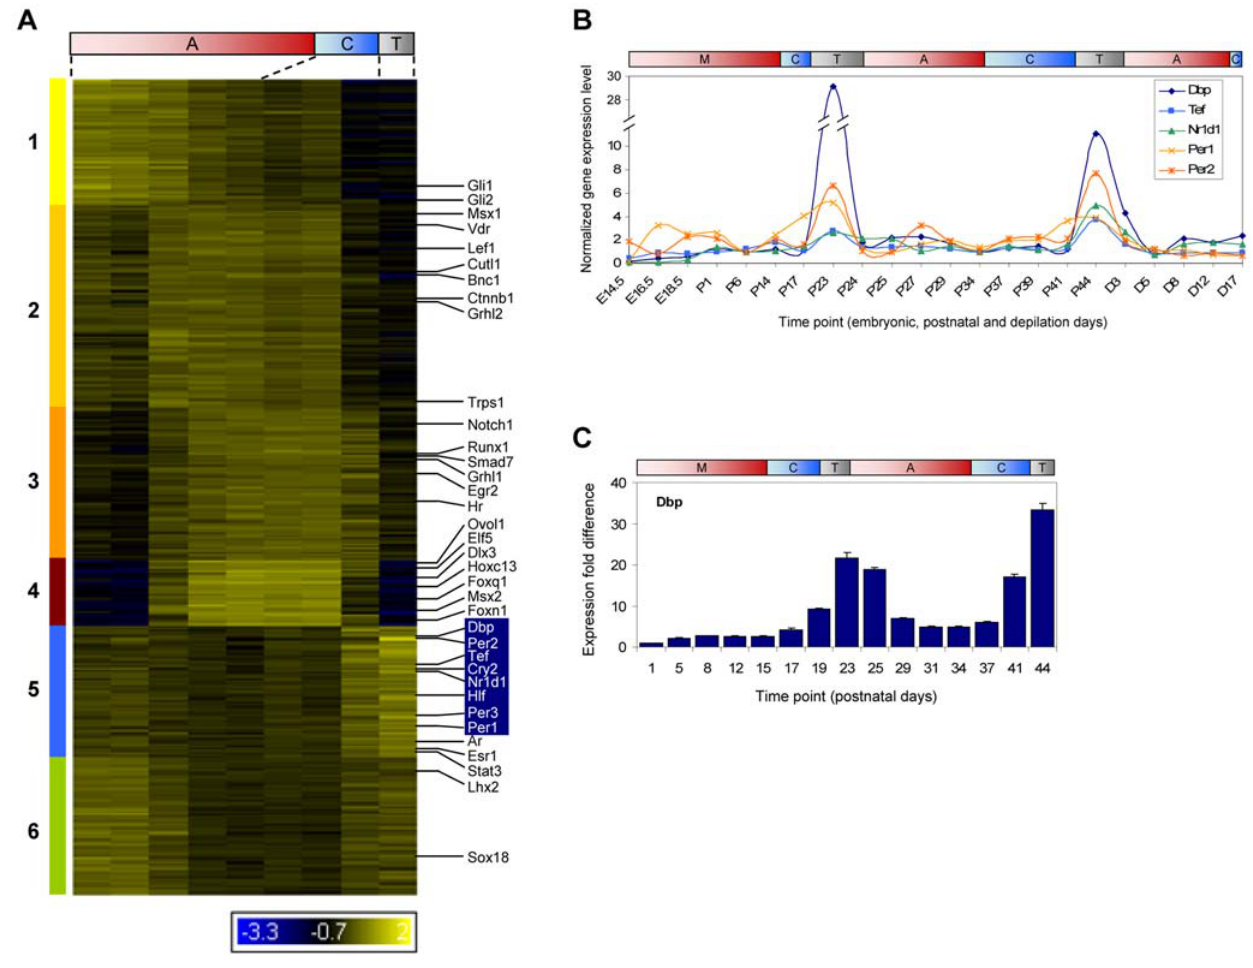
Figure 2. CLOCK–regulated genes are periodically expressed during hair follicle cycling. (A) Temporal clusters (labeled 1–6 and color coded) of hair cycle-regulated transcriptional regulators. Transcription factors that play key roles in hair follicle morphogenesis and/or cycling are labeled with gene symbols in black. CLOCK-regulated genes are labeled in the blue box. Expression levels are from profiling data of the second hair growth cycle and are indicated by the colorimetric ratio-scale. (B) Time-course profiles of CLOCK-controlled genes during hair follicle morphogenesis, the first two natural and depilation-induced hair growth cycles. For each gene, the expression levels were normalized relative to the lowest expressed time point of the second cycle; the first cycle (P1 to P23) was normalized separately because different array was used for profiling. Differences in magnitude of change between the first and second cycles are primarily due to differential probe set efficiencies. Note the broken y-axis. E – embryonic days; P – postnatal days; D - depilation days. (C) Q-PCR of Dbp using independent samples from the first two synchronized hair growth cycles. Standard deviations were determined by using three replicates normalized to Gapdh and fold calculated relative to the lowest expression sample. For (B–D), time points are mapped based on histology to the corresponding phases of the cycle: hair follicle morphogenesis (M), anagen (A), catagen (C), and telogen (T).